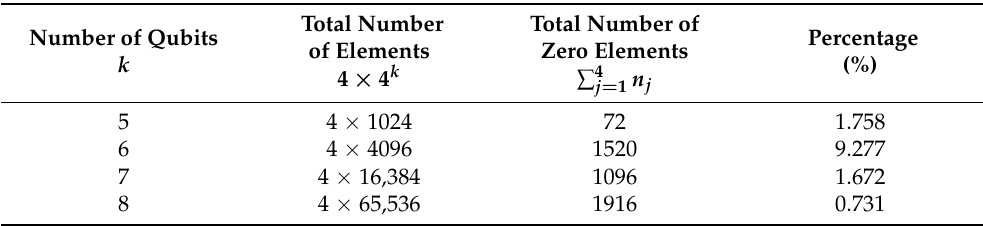
Table 2. The change in the number of zero elements with an increase in the number of calculat- ing qubits.